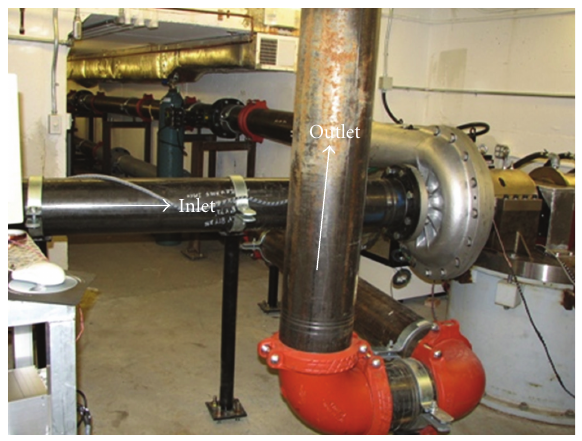
Figure 1: Photograph of the compressor test